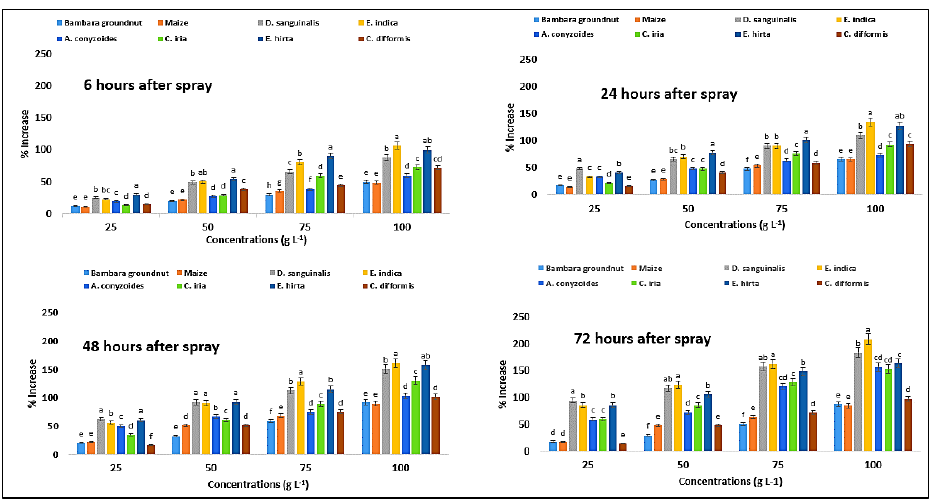
Figure 15. Percent increase in catalase (CAT) content of test crops and weeds treated with parthenium leaf methanol extract concentrations at different associated times. Values with the same letter among the tested crops and weeds are not significantly different at the same extract concentrations at p ≤ 0.005, by Tukey ’ s HSD.